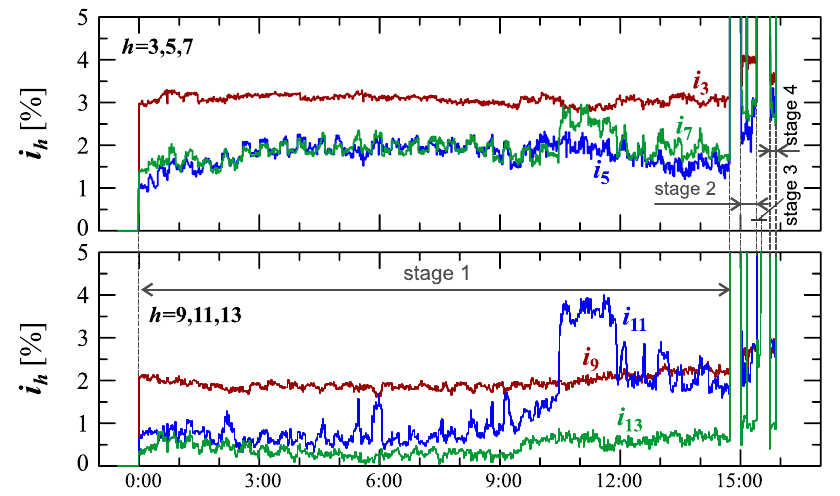
Figure 33. The characteristics of odd harmonics of the current i h = f ( t ) from the order h = 3 to 13 for Case